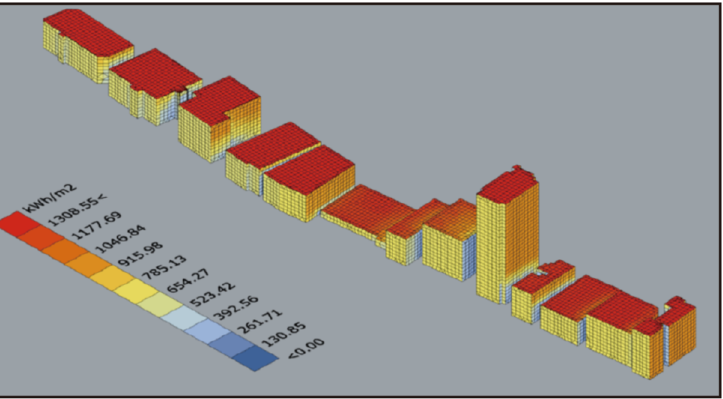
Figure 4. Annual radiation amount (kWh · m − 2 ) on the surfaces of the existing buildings calculated by Grasshopper. The direction of increasing radiation in the colorbar represents north.